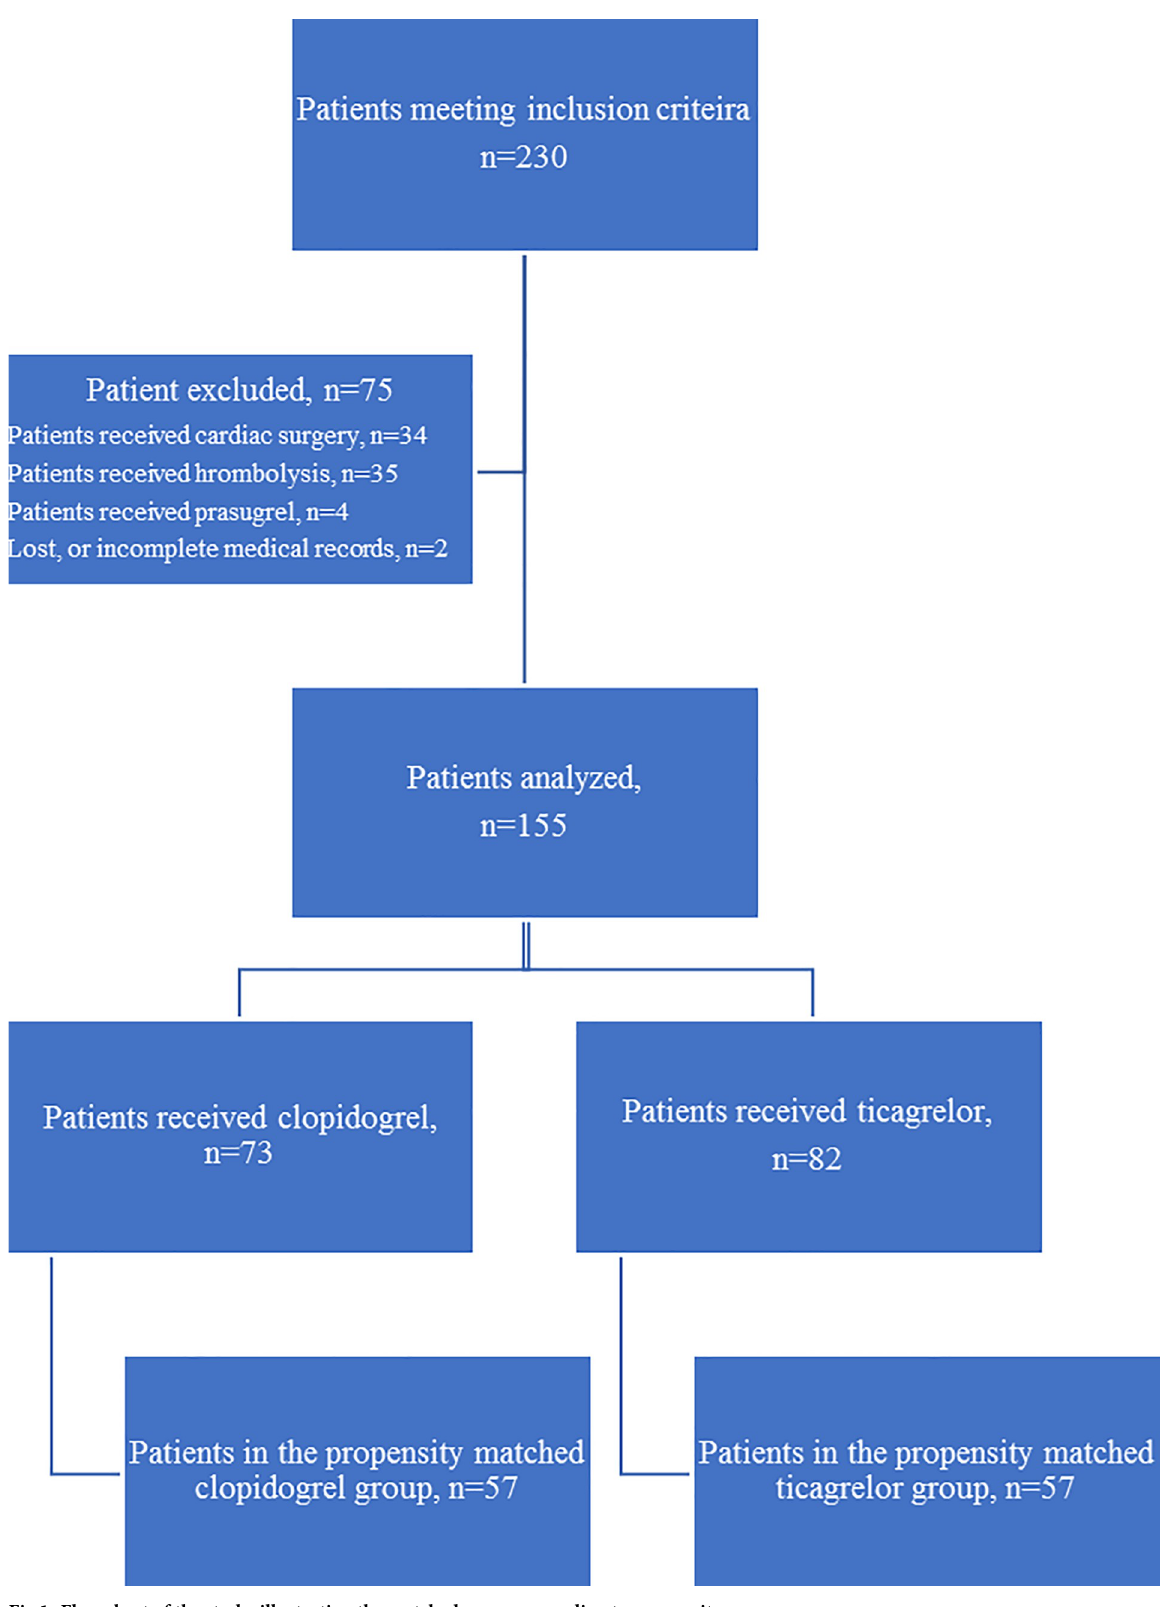
Fig 1. Flow chart of the study, illustrating the matched groups according to propensity score. https://doi.org/10.1371/journal.pone.0232768.g001 PLOS ONE | https://doi.org/10.1371/journal.pone.0232768 May 4,